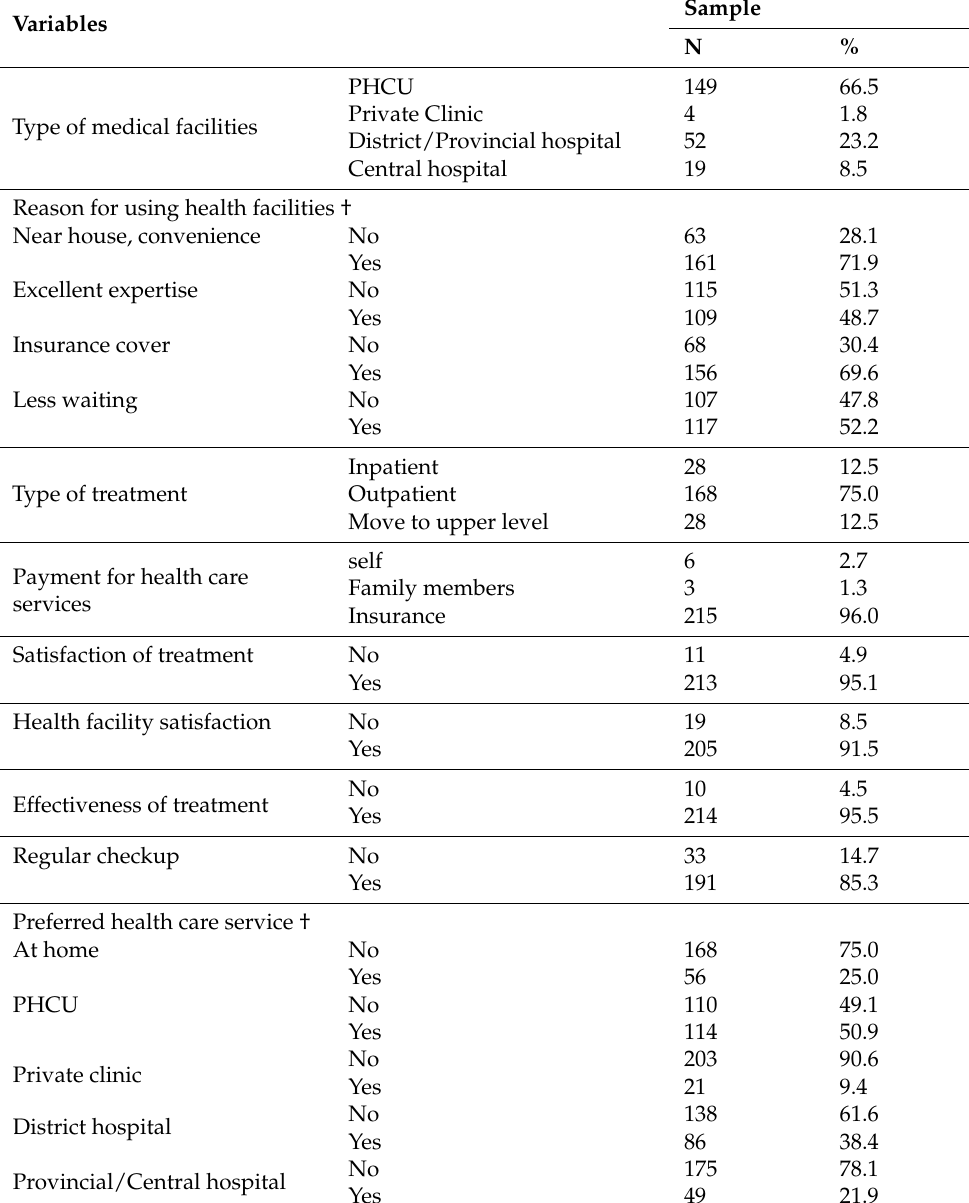
Table 2. Health-seeking behavior of the study population who have utilized medical facilities within the last 6 months ( n =